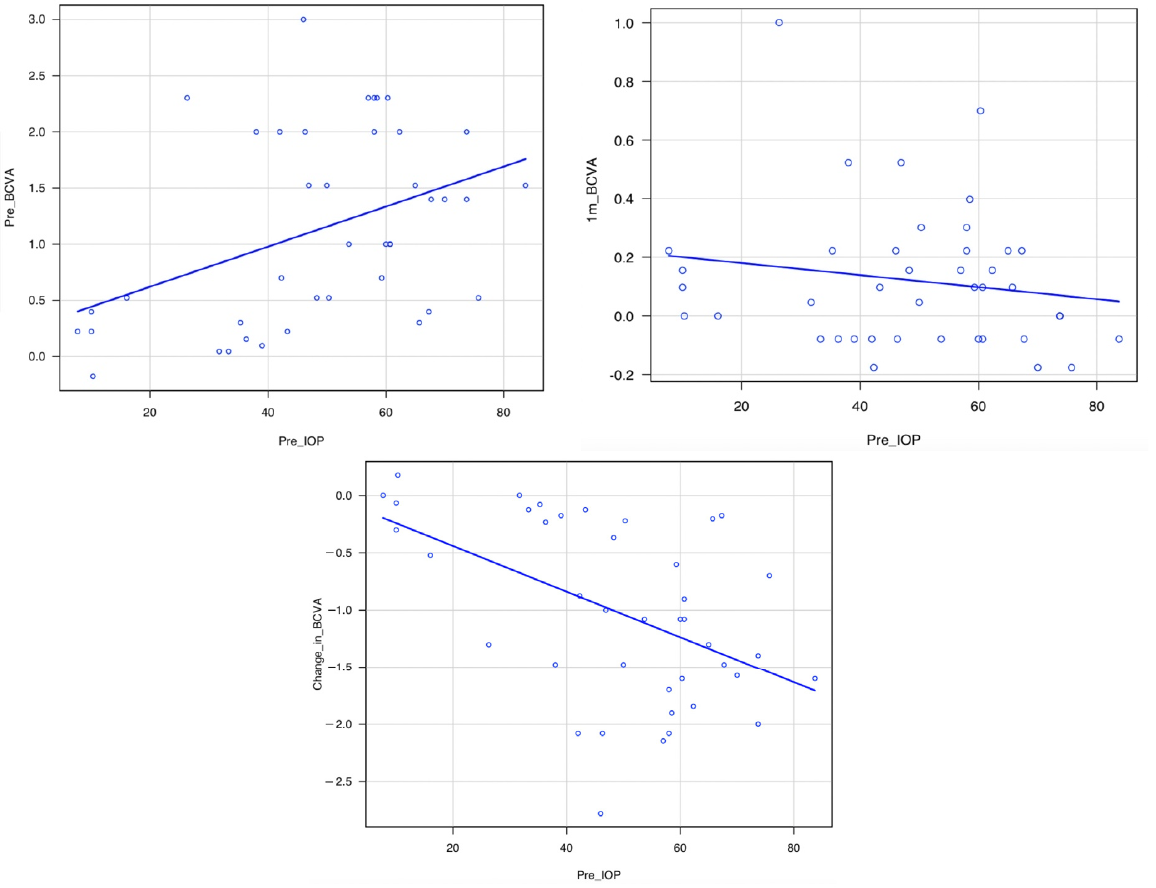
Figure 2. Correlation between Pre-IOP and Pre-BCVA, Pre-IOP and 1m-BCVA, and Pre-IOP and Change in BCVA. The pre-IOP and pre-BCVA and pre-IOP and change in BCVA for all 41 eyes were significantly correlated ( p = 0.0080, r = 0.41, p = 0.0010, r = − 0.50, respectively); however, pre-IOP and 1m-BCVA were not significantly correlated ( p = 0.31). Abbreviations: BCVA: LogMAR-converted best corrected visual acuity, IOP: intraocular pressure (mmHg), Pre-BCVA: BCVA at the first visit, Pre-IOP: IOP at the first visit (mmHg), 1m-BCVA: BCVA at 1 month, and Change in BCVA: Change in BCVA from first visit to 1 month.